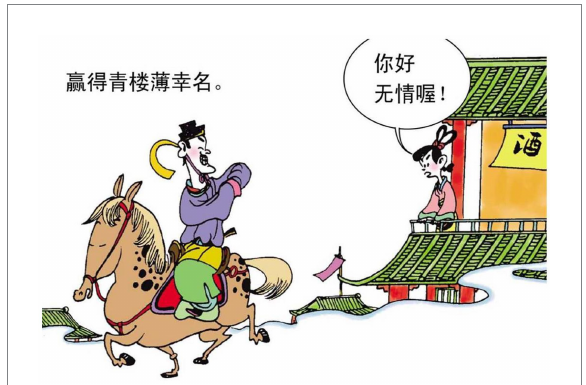
FIGURE 15 The fifth panel on Cai (2014, p. 99). Images reproduced with permission from Shang Dong People Press.